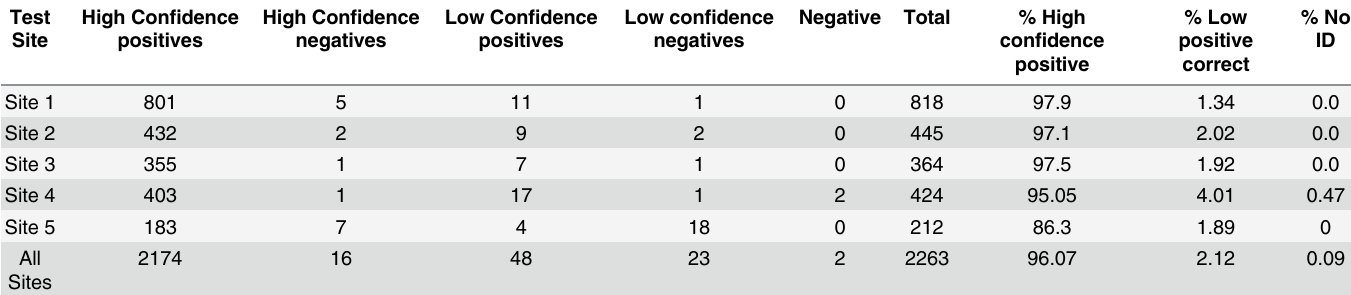
Table 2. Performance of MBT-CA